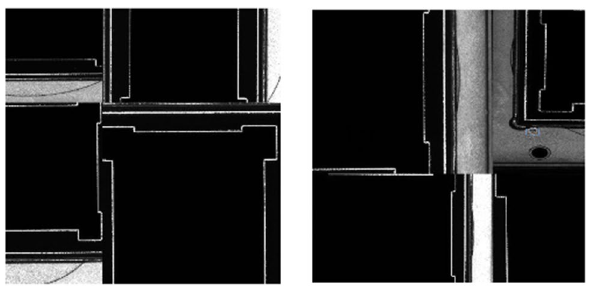
Figure 6. Demonstration of mosaic data enhancement method on sample image.